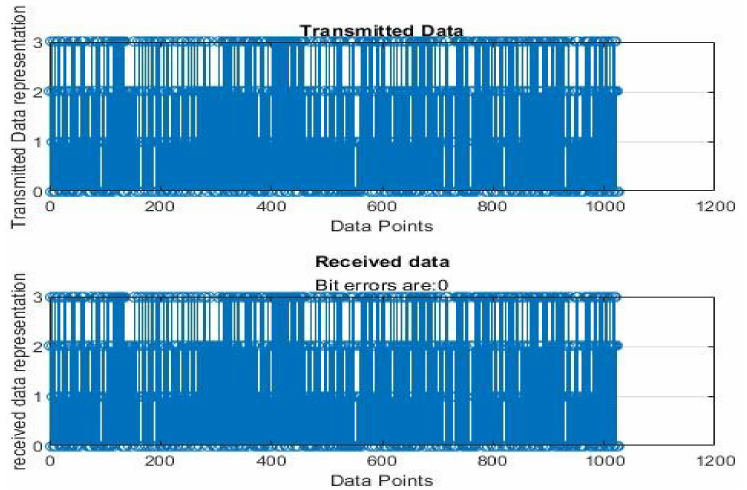
Figure 8. GAWDO QPSK output for 1024 data points in a noiseless channel.